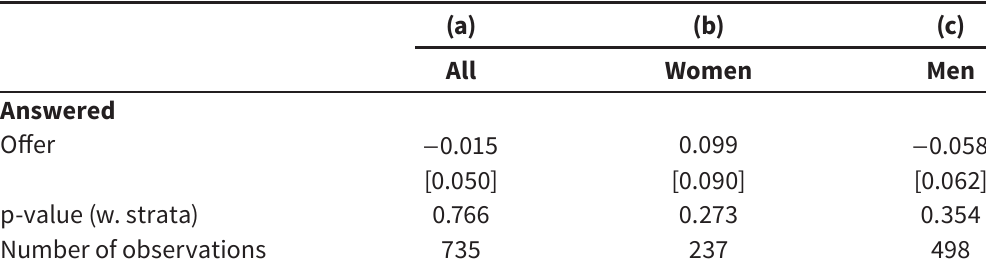
Atrition (answered non-cognitive module), All Inter-viewed Subscribers and by Gender Group